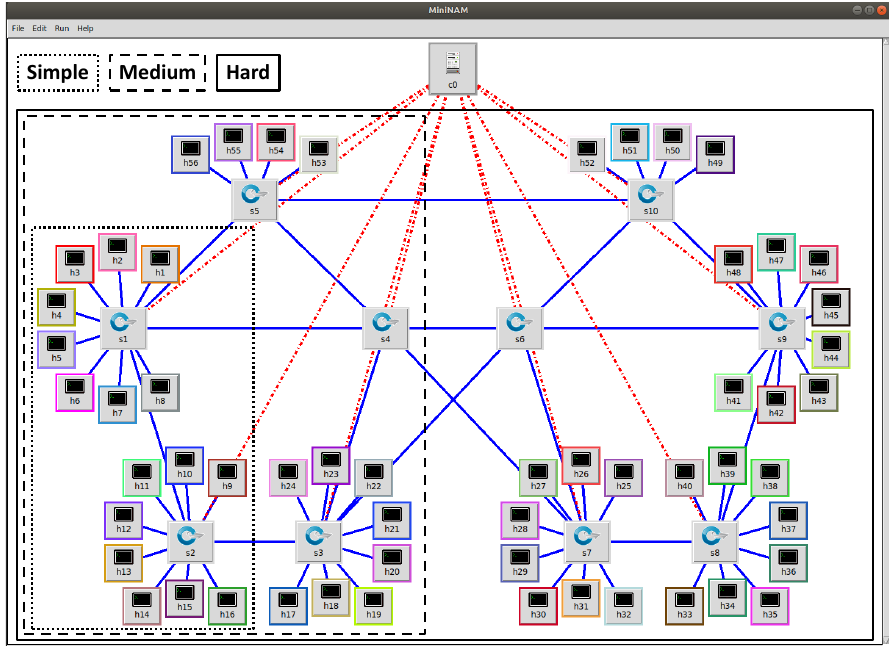
Figure 6. Network topologies used in the